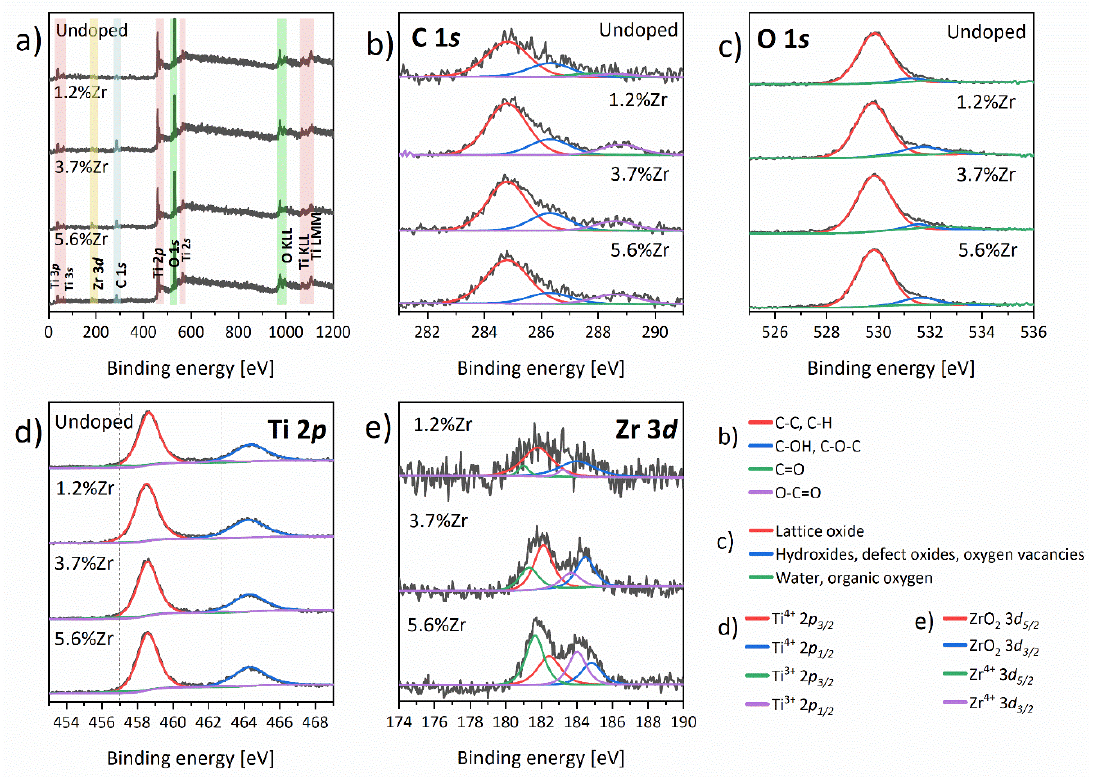
Figure 10. XPS spectra of nanoparticles annealed at 450 °C: ( a ) full scan, ( b ) C 1s, ( c ) O 1s, ( d ) Ti 2p (dotted line – Ti 3+ 2p 3/2 and 2p 1/2 ), and ( e ) Zr 3d.